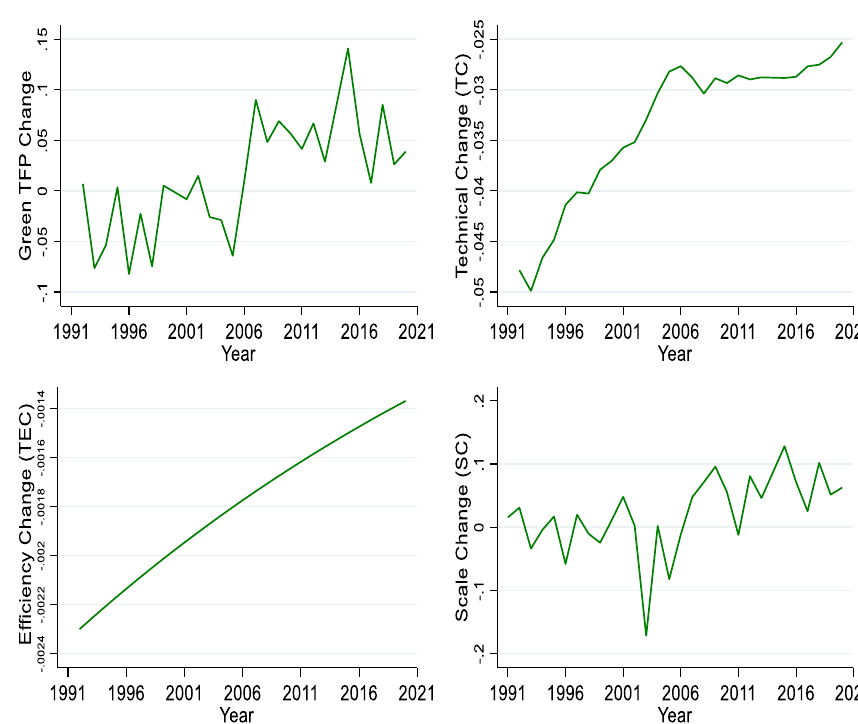
Fig. 3 Mean green TFP change components for the period